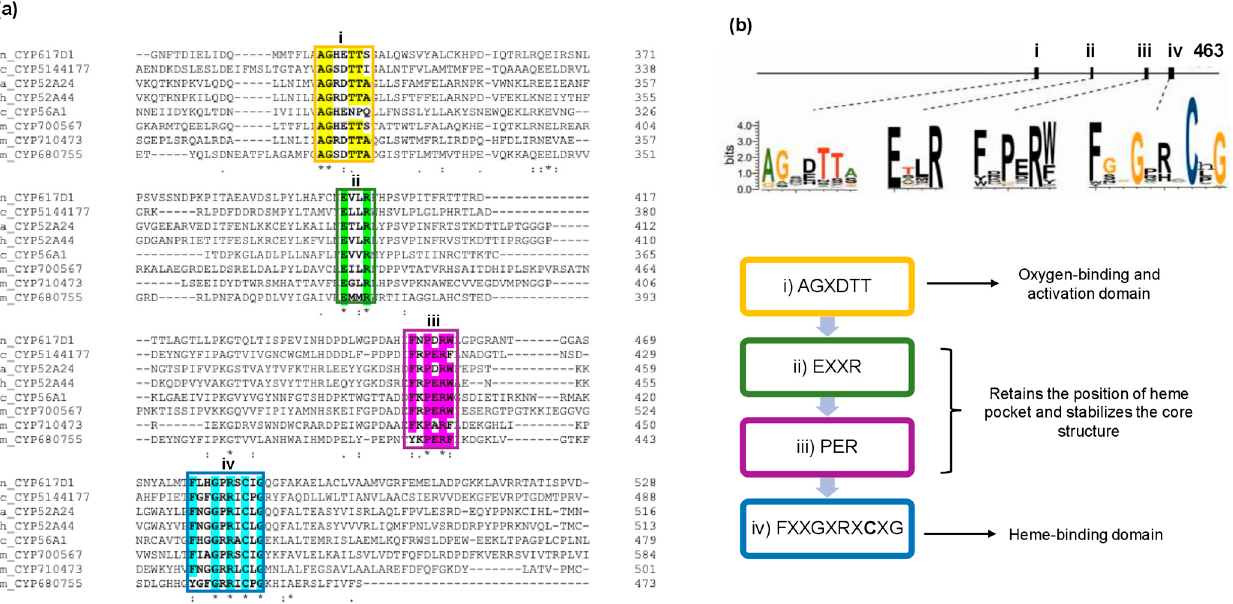
Figure 6. Molecular alignment of the CYP proteins and their conserved motifs. ( a ) Sequence align- ment of the CYP proteins identified in different fungal and yeast species: An , Aspergillus nidulans ; Pc, Phanerochaete chrysosporium ; Ca: Candida albicans ; Dh, Debaryomyces hansenii; Rm, Rhodotorula mucilaginosa and Sc, Saccharomyces cerevisiae . The conserved domains labelled as i–iv are shown inside the colored boxes and they are explained in detail in the text. The Clustal Omega online tool was used to perform the analysis (https://www.ebi.ac.uk/Tools/msa/clustalo/ accessed on 22 June 2020) [33]. The positions containing a single and fully conserved residue are marked with (*); the conserved groups with highly similar properties are marked with (:); the conserved groups with properties bearing weak similarity are marked with (.) [33]. ( b ) Conserved sequences of the eukaryotic CYP motifs [25,44]. The boxes indicate the function of the respective motifs.